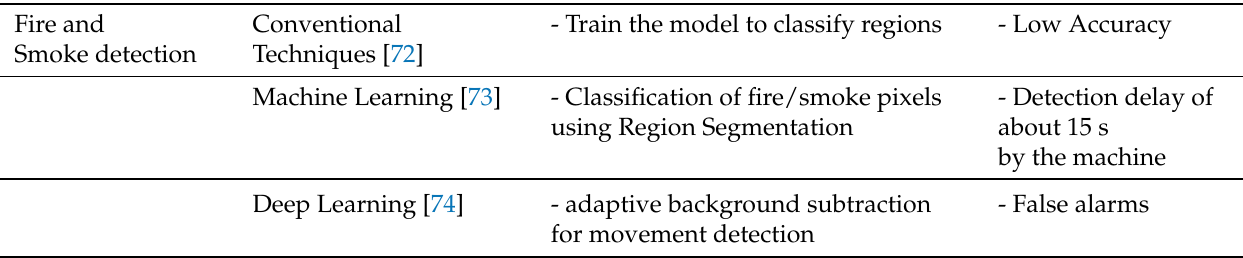
Table 11. Comparison between methods used in